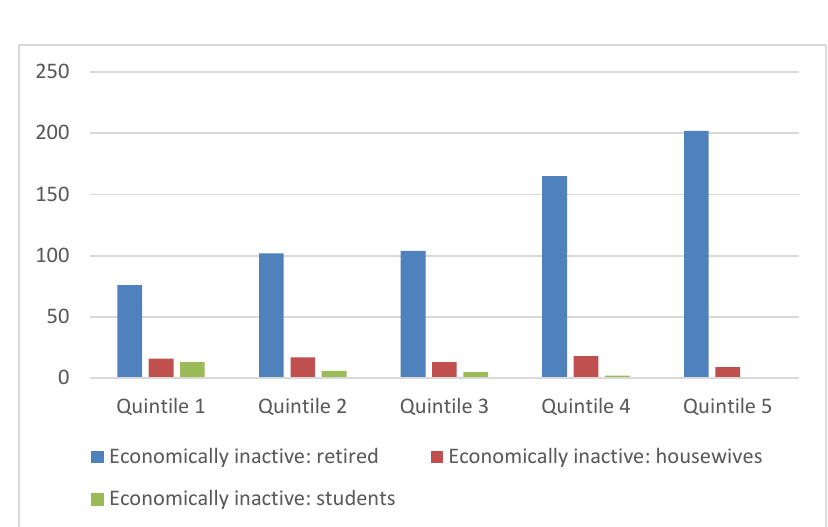
FIGURE 2: Analysis of economically inactive group per net equity quintile Source: Authors’